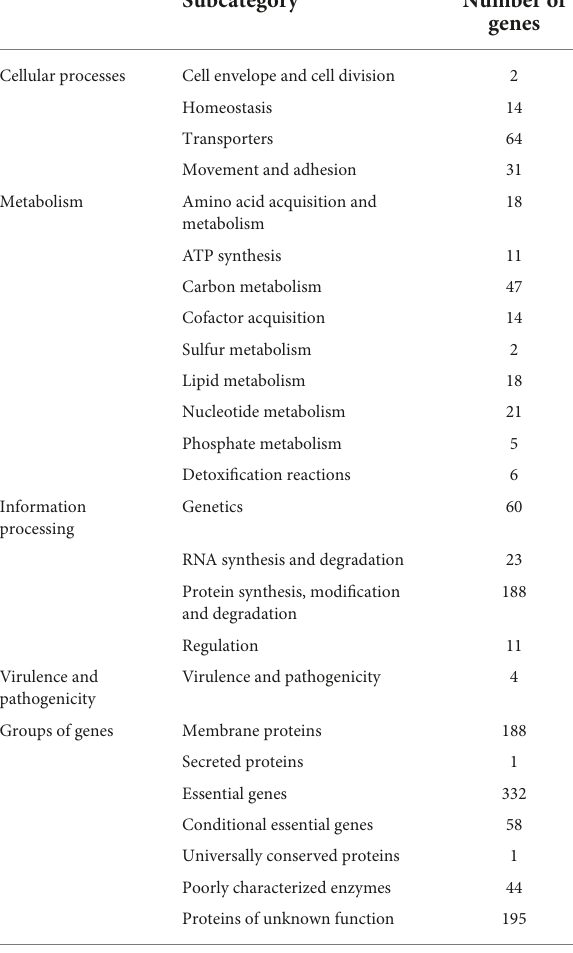
TABLE 1 List of top-level categories and their subcategories used in Myco Wiki, and the number of genes assigned to each of them.